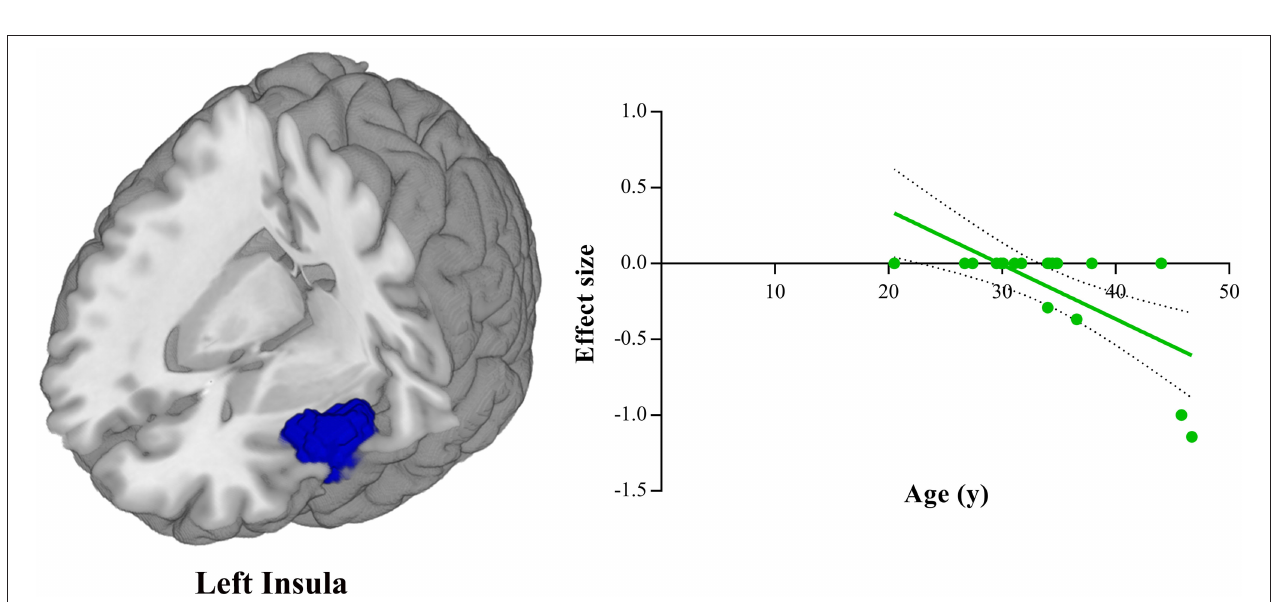
FIGURE 3 | Meta-regression analysis shows that Hamilton Depression Rating Scale (HDRS) score of depressed patients is negatively correlated with gray matter volume in the right amygdala. In the graphs, the effect sizes needed to create this plot have been extracted from the peak of maximum slope significance, and each study is represented as a dot. The regression line (meta-regression signed differential mapping slope) is shown.